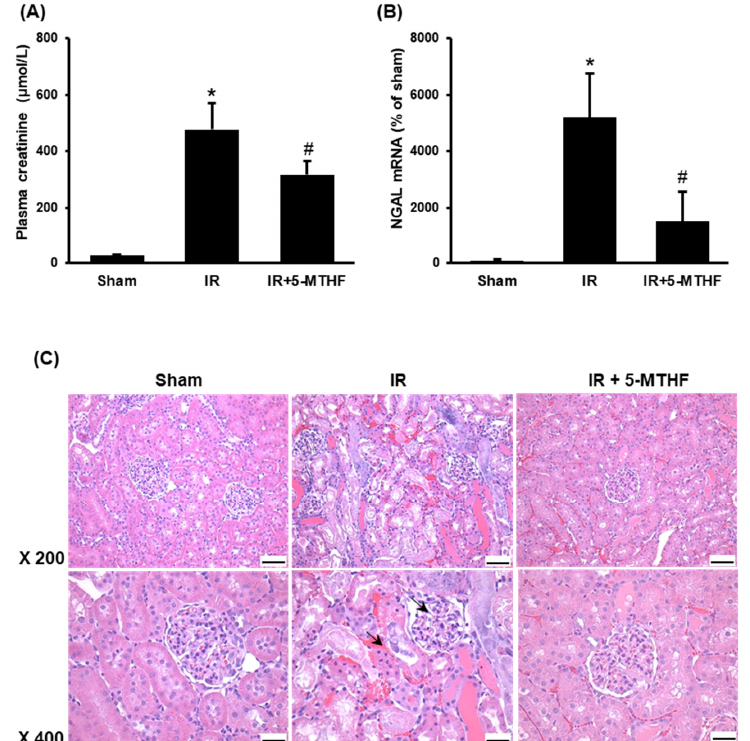
Figure 1. Kidney injury. Rats were subjected to sham operation (Sham), kidney ischemia-reperfusion (IR) or ischemia-reperfusion with 5-MTHF injection (IR + 5MTHF). ( A ) Plasma creatinine and ( B ) kidney NGAL mRNA were measured. Results are expressed as mean ± SD ( n = 5–8). * p < 0.05 when compared with the value obtained from the Sham group. # p < 0.05 when compared with the value obtained from the IR group. ( C ) Representative hematoxylin and eosin (H&E) staining images of kidney sections are shown (magnification ×200, ×400). Arrows point to the area with red blood cell accumulation and irregular glomerular structure. The bar on the images represents 100 µm.